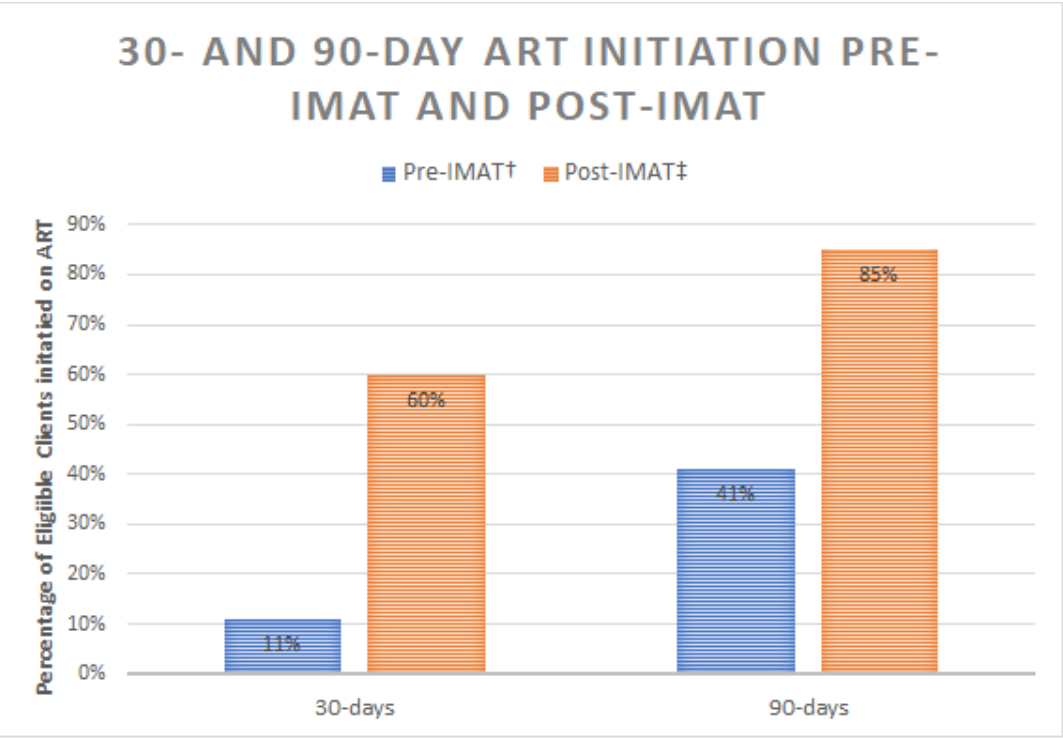
Figure 2. Proportion of eligible clients receiving ART pre- and post-IMAT. This figure describes the percentage of eligible opioid treatment program clients (pre-IMAT, post-IMAT) who were initiated on ART within 30 and 90 days of their eligibility. † Pre-IMAT (n = 17) Eligible based on CD4 count. ‡ Post-IMAT, (n = 20) Eligible based on CD4 count (before guideline change); 2.07-fold increase in 90-day ART initiation ( p <